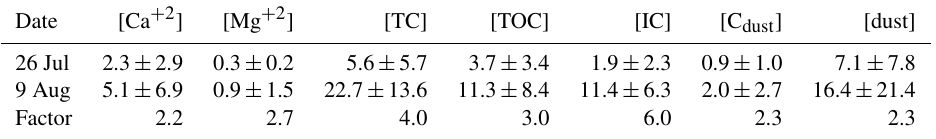
Table 5. Mean concentrations ( ± 1 σ ) of major ions and carbon along the Haig centreline transect surveys on 26 July and 9 August 2017 ( N = 11). All concentrations have units mgL − 1 . TC is total carbon, TIC and OC are inorganic and organic carbon, [C dust ] is the inorganic carbon associated with carbonate mineral dust, and [dust] is the total mineral dust. Factor indicates the ratio of concentrations for 9 August over 26